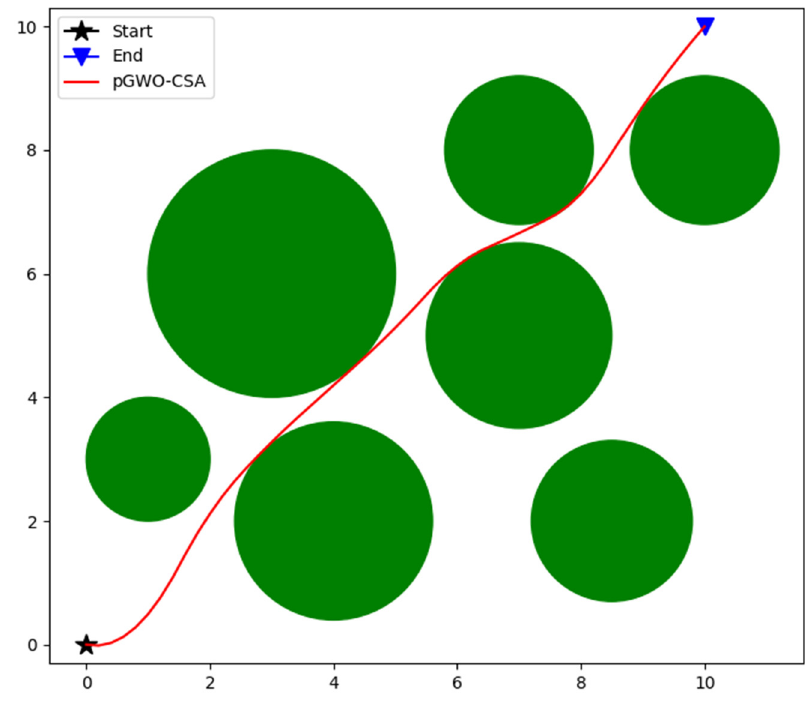
Figure 36. The path of pGWO-CSA.